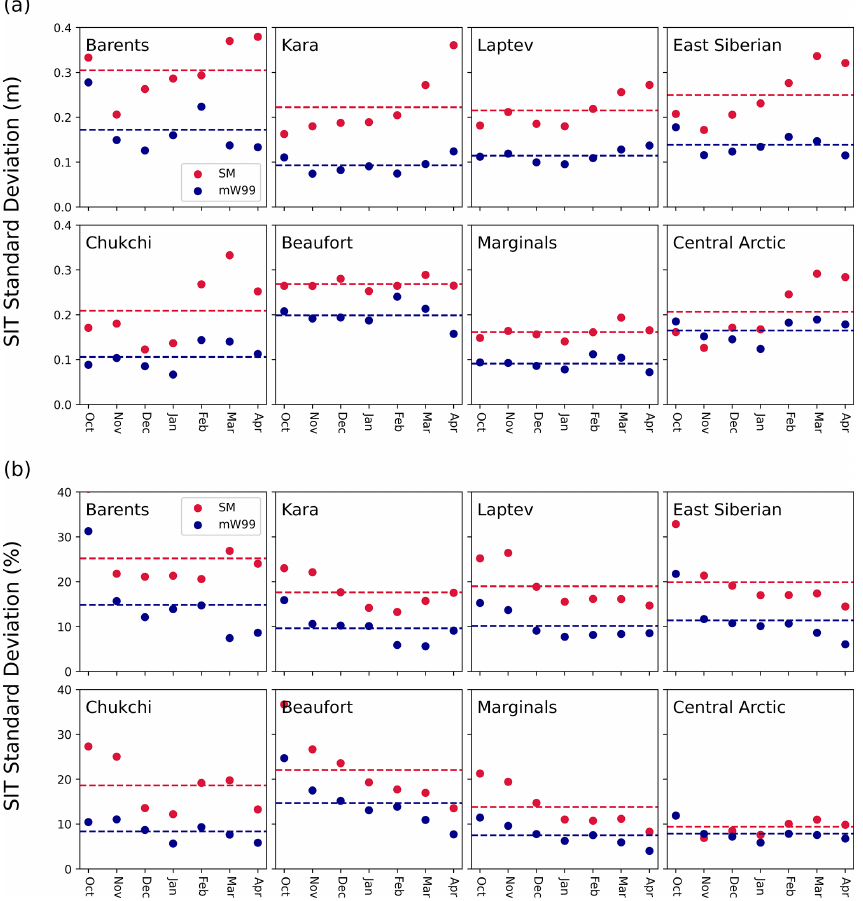
Figure 9. Standard deviation in sea ice thickness over the period 2002–2018 except for the Central Arctic: 2010–2018 (a) calculated in absolute terms and (b) calculated as a percentage of the regional mean thickness over the period. Mean growth-season values shown with dashed lines. The individual detrended regional time series from which this figure is synthesised are available in Fig.